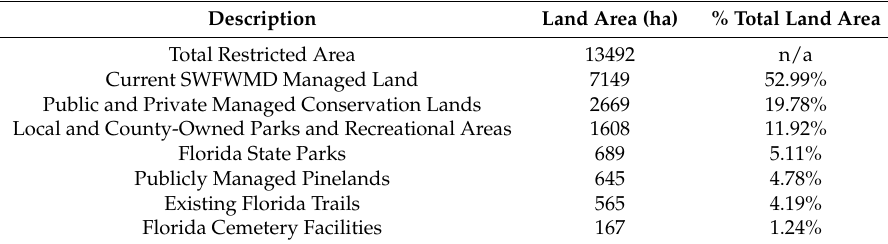
Table 4. Restricted area classes and their contribution to the Total Restricted Area.